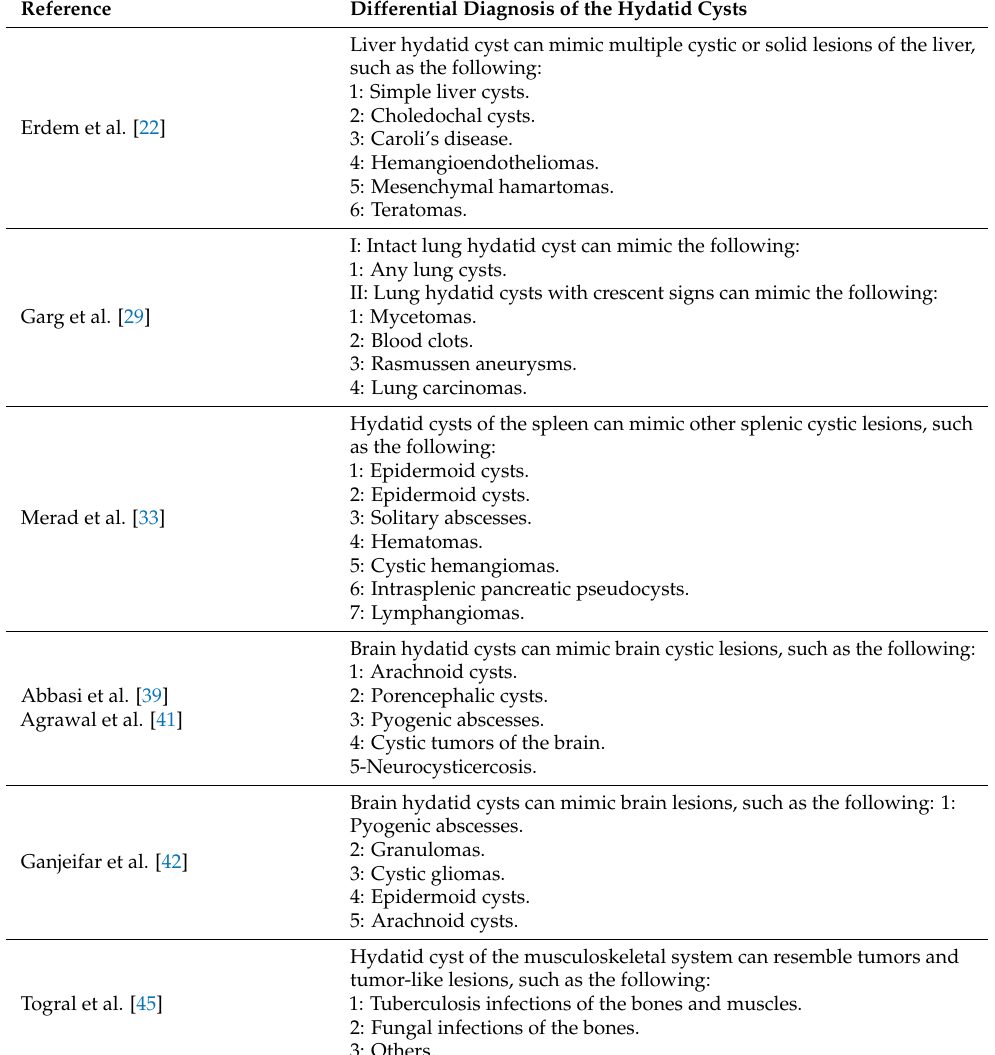
Table 1. List of differential diagnoses of hydatid